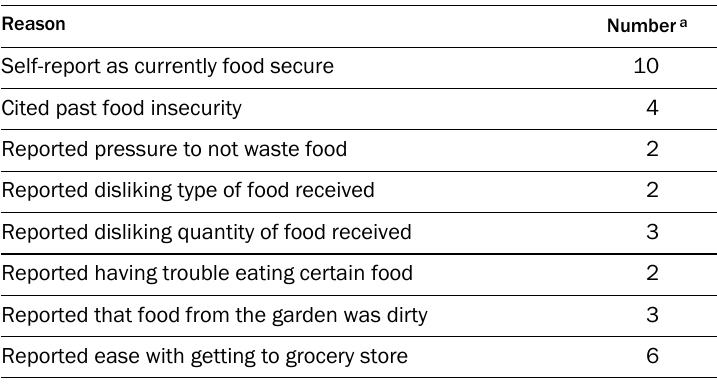
Table 2. Senior Nonparticipants’ Reasons for